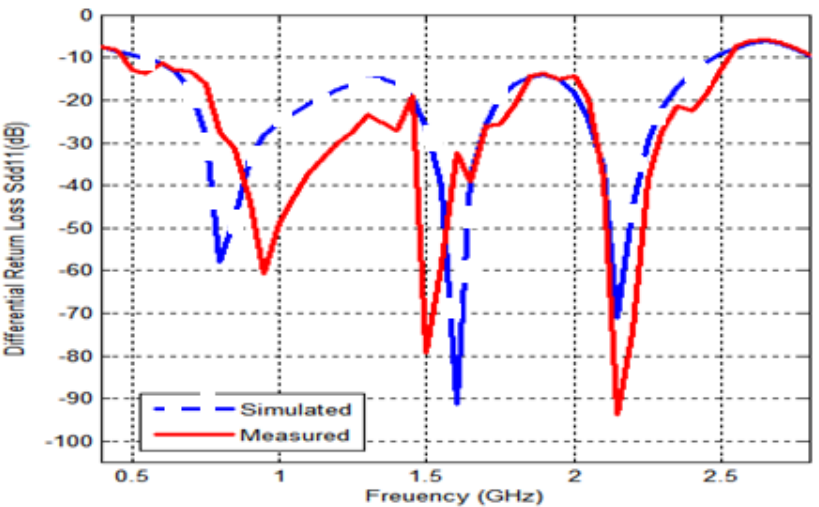
Figure 3. The simulated and measured differential return loss, S